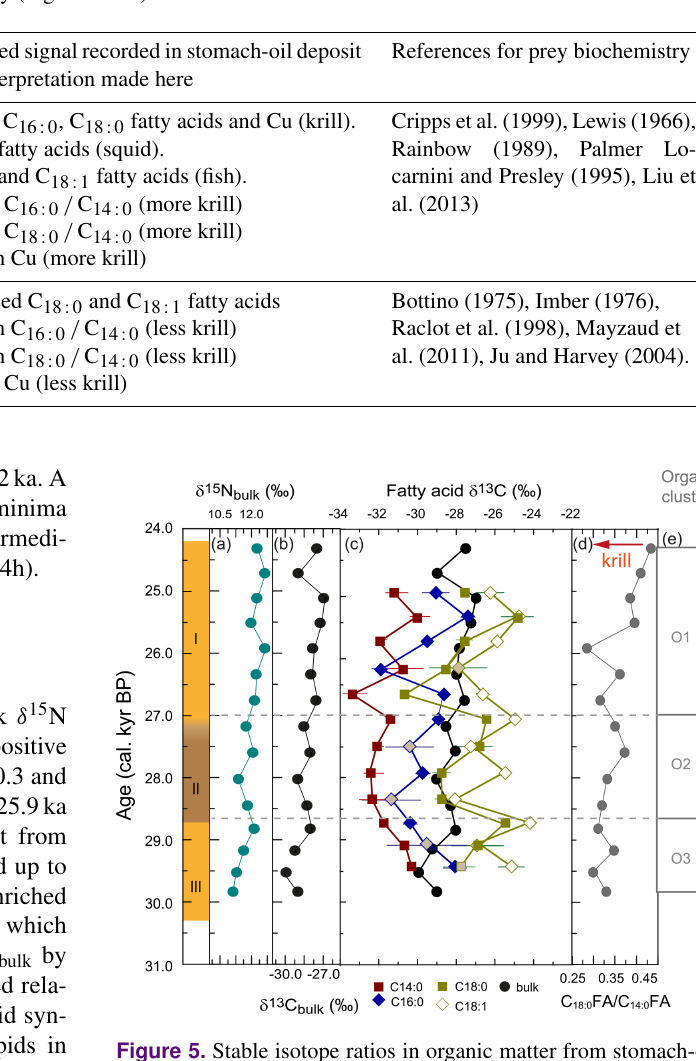
contrast, from 28.4 ka the δ 13 C 14 : 0 correlated with δ 13 C 18 : 0 , and δ 13 C 16 : 0 correlated with δ 13 C 18 : 1 . Cluster analysis on the lipids, pigments, and stable isotope data identified three zones (Figs. 4j, A3). The lower zones aligned with Units III and II, but the upper zone